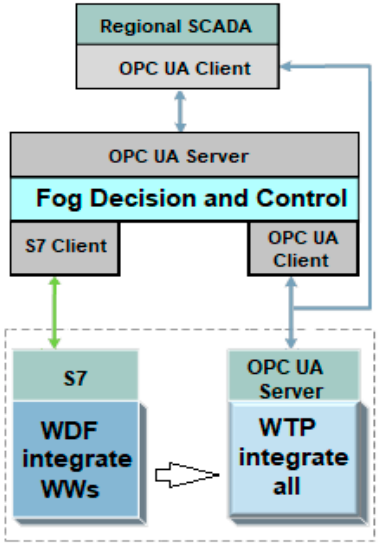
Figure 5. FDC solution integration in the tested scenario.